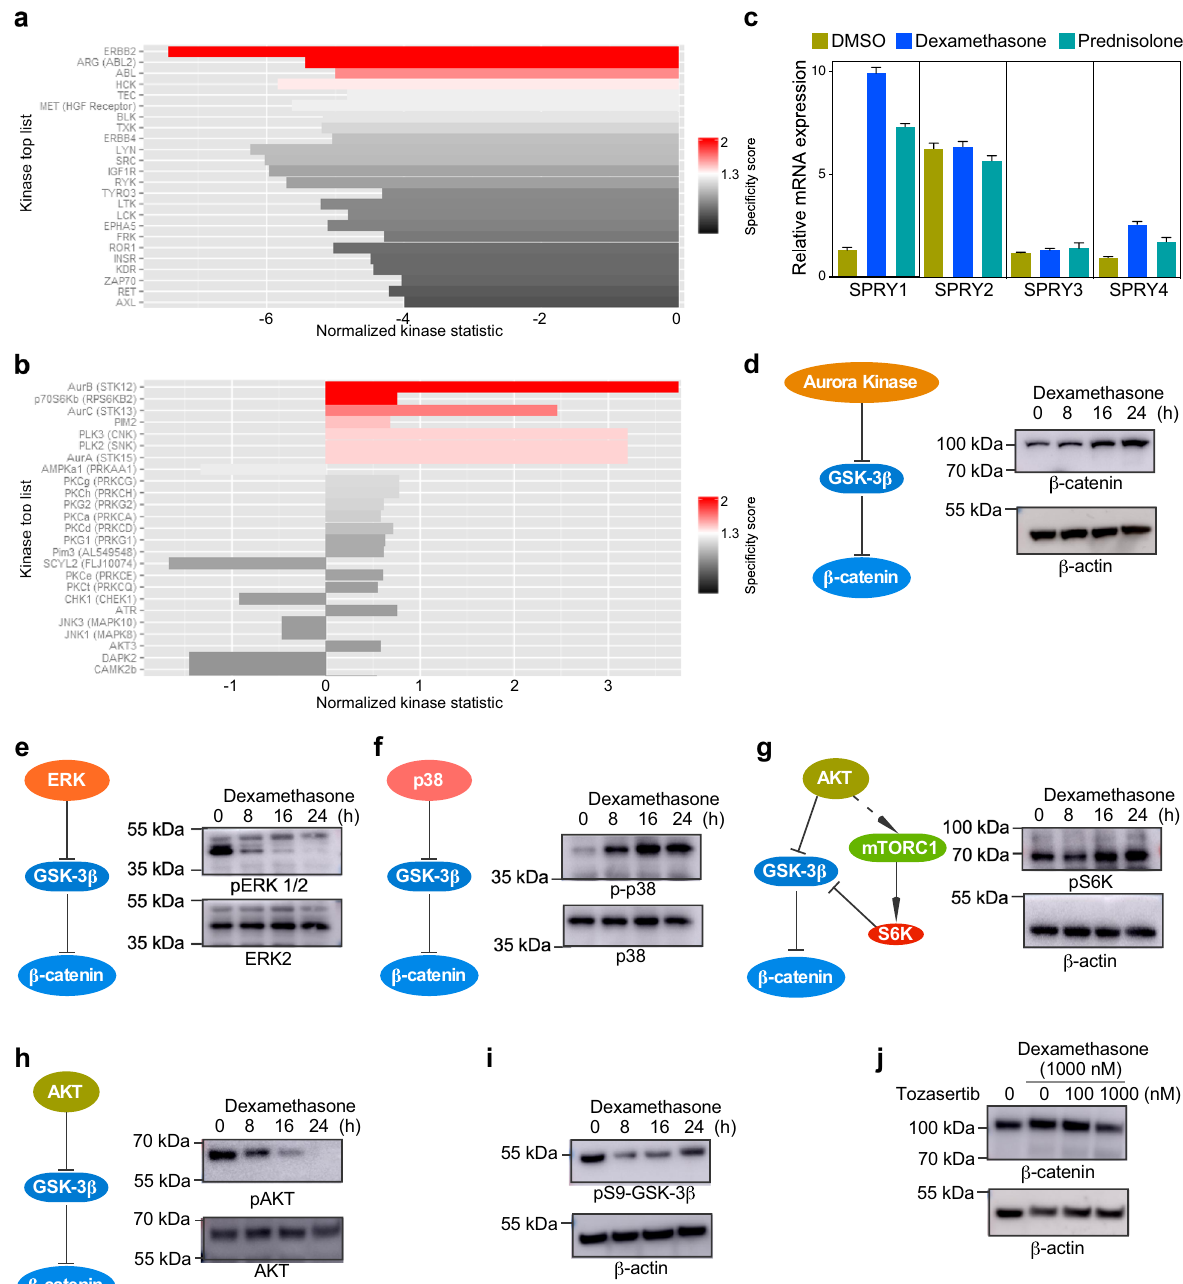
Fig. 2 Glucocorticoid-induced regulation of kinase activation. SUP-B15 cells were treated with 1 µM dexamethasone or DMSO for 6 h before lysis. a To measure protein tyrosine kinase activity in dexamethasone-treated cells, lysates were applied in Pamgene peptide substrate-based tyrosine kinase array and analyzed for tyrosine kinase activity using Pamgene software. b To measure protein serine/threonine kinase activity in dexamethasone-treated cells, lysates were applied in Pamgene peptide substrate-based serine/threonine kinase array and analyzed for serine/threonine kinase activity using Pamgene software. c Changes in the expression of Sprouty family genes in dexamethasone and prednisolone-treated SUP-B15 cells compared to DMSO-treated cells. Error bars show standard deviation. d – i SUP-B15 cells were treated with 1 µM dexamethasone for the indicated time period before lysis. Lysates were analyzed by SDS-PAGE and western blotting using speci fi c antibodies as labeled. j SUP-B15 cells were treated with 1 µM dexamethasone and with different concentrations of Tozasertib for 24 h before lysis. Lysates were analyzed by SDS-PAGE and western blotting using speci fi c antibodies as labeled. Blots shown in each panel were from the same experiment and processed